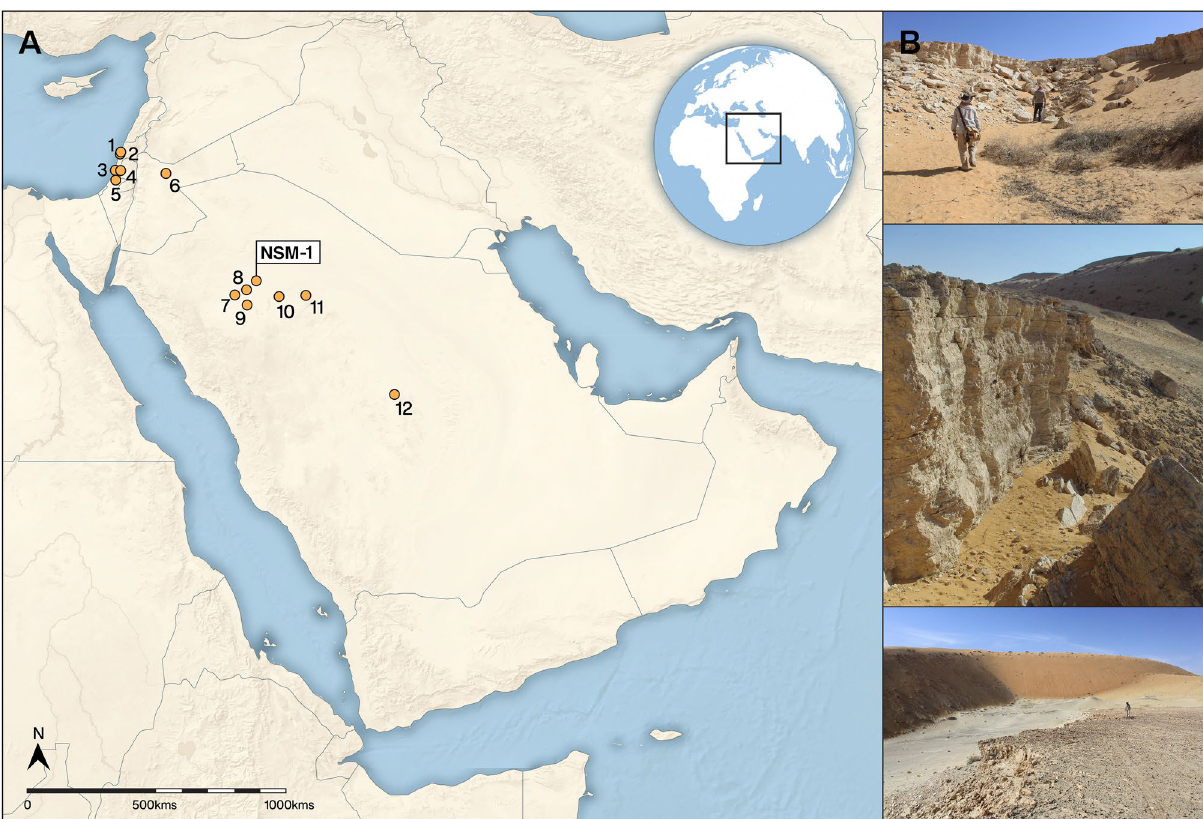
Figure 1. Map of Arabia with the site of An Nasim (NSM-1) and key Levantine and Arabian sites, including those discussed in the text. Tabun (1), Misliya (2), Holon (3), Qesem (4), Revadim (5), Azraq (6), Khabb Musayyib-2 (7) 21 , Khall Amayshan-1 (8) 21 , Ti’s al Ghadah (9) 25,38,39 , Al Marrat-6 (10) 15,40 , Al Qana-1 (11) 15,41,42 , Saffaqah (12) 18,19,43 . The map was created using QGIS 3.12 https:// qgis. org/ en/ site/ and the Natural Earth Database from https:// www. natur alear thdata. com/ downl oads/ and Adobe Illustrator